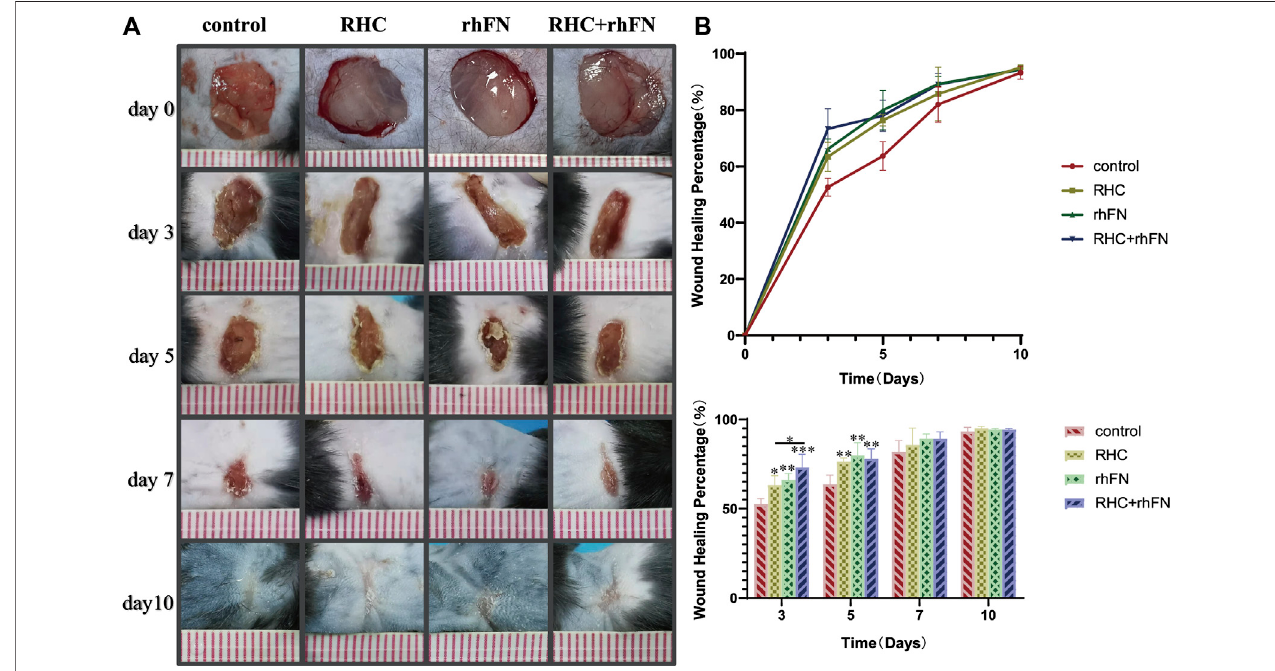
FIGURE 6 | The analysis of wound healing rate. (A) Representative photographs on PID 3, 5, 7 and 10. (B) Calculation and comparison of wound healing percentage on PID 3, 5, 7 and 10. Data are presented as the mean ± SD ( n = 5). Statistical analysis: p p < 0.05, pp p < 0.01, ppp p <